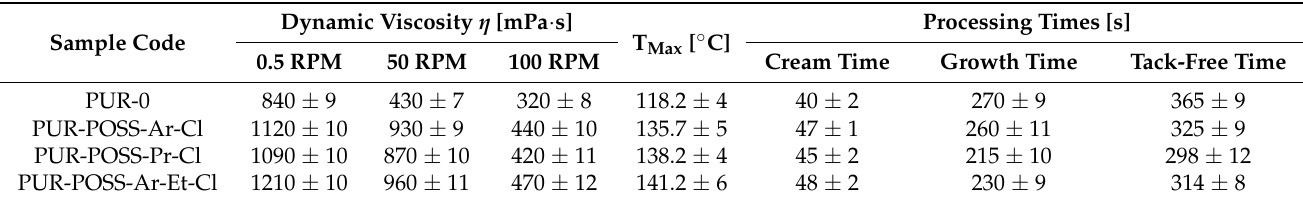
Table 1. The impact of POSS-Cl on viscosity and growth kinetic of polyol